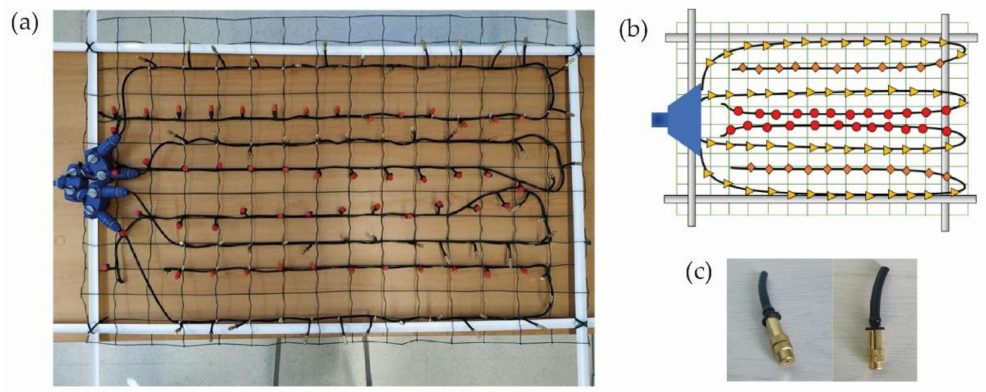
Figure 3. ( a ) Figure showing the second aluminum hanging structure, ( b ) dripper placement scheme, and ( c ) new type of dripper.